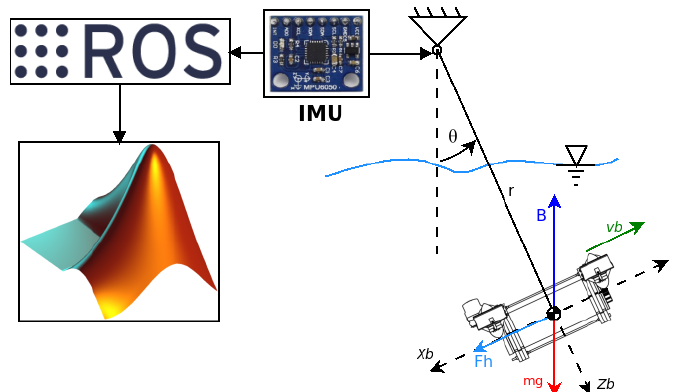
Figure 9. On the right, the free body diagram used for modelling the body oscillating underwater is shown, where Θ is the angle; r is the pendulum length; B is the buoyancy; m is the mass; g is the gravity acceleration (9.79 m ); v b is the body velocity; X b and Z b are the axes of the reference body system, s 2 respectively; and F h is the hydrodynamical force. The angle is measured by an IMU, which sends the info to ROS, after which it is processed in Matlab.